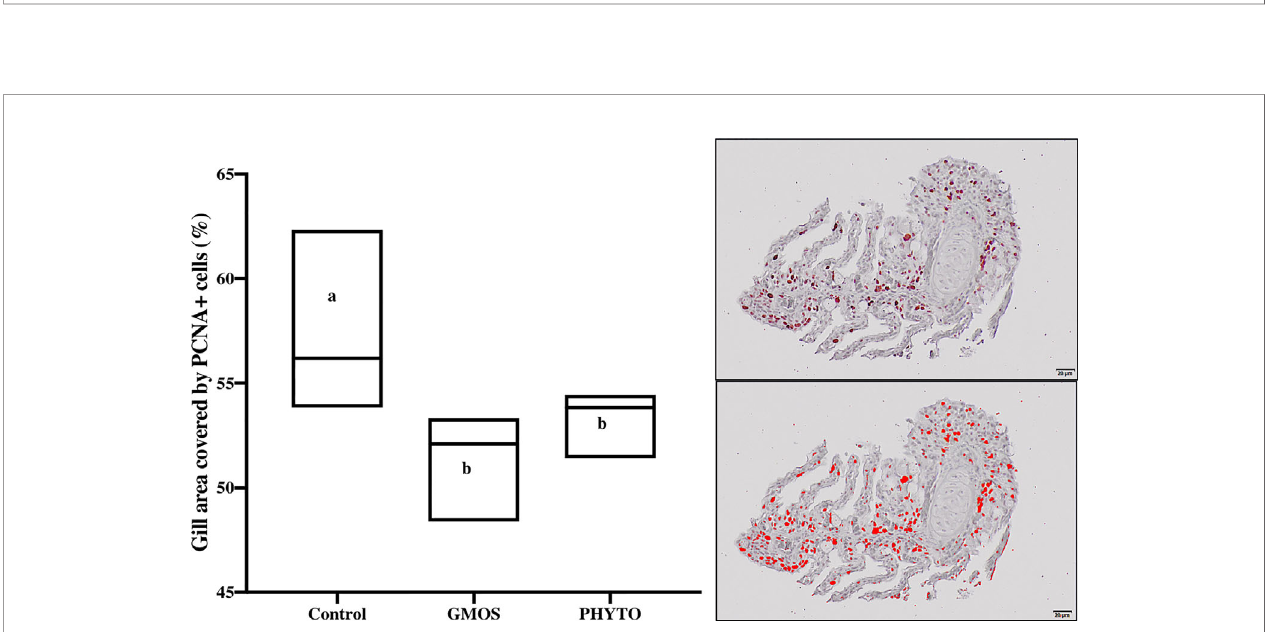
FIGURE 7 | Total gill epithelium covered by PCNA+ cells on transversal sections at the end of the feeding trial (63 days). Observe as fi sh fed GMOS and PHYTO diets presented lower coverage of PCNA+ cells compared to fi sh fed control diet. Boxes in boxplot represent mean ± SD. Different letters denote signi fi cant differences among dietary treatments (p ≤ 0.05; oneway ANOVA; Tukey). Observe the automatically detected immunopositivity (marked in red) comparing the graph accompanying